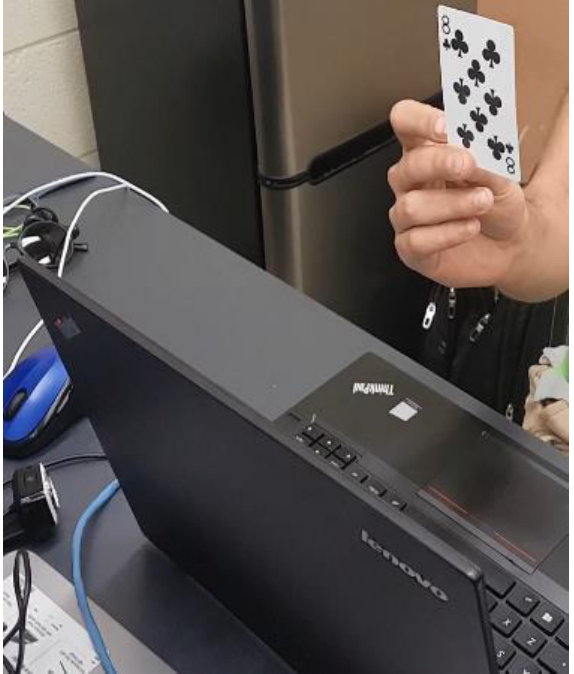
Figure 9. Experimental setup in which laptop is controlling the robot as shown in Figure 8. A playing card is shown to the laptop webcam to perform object detection.